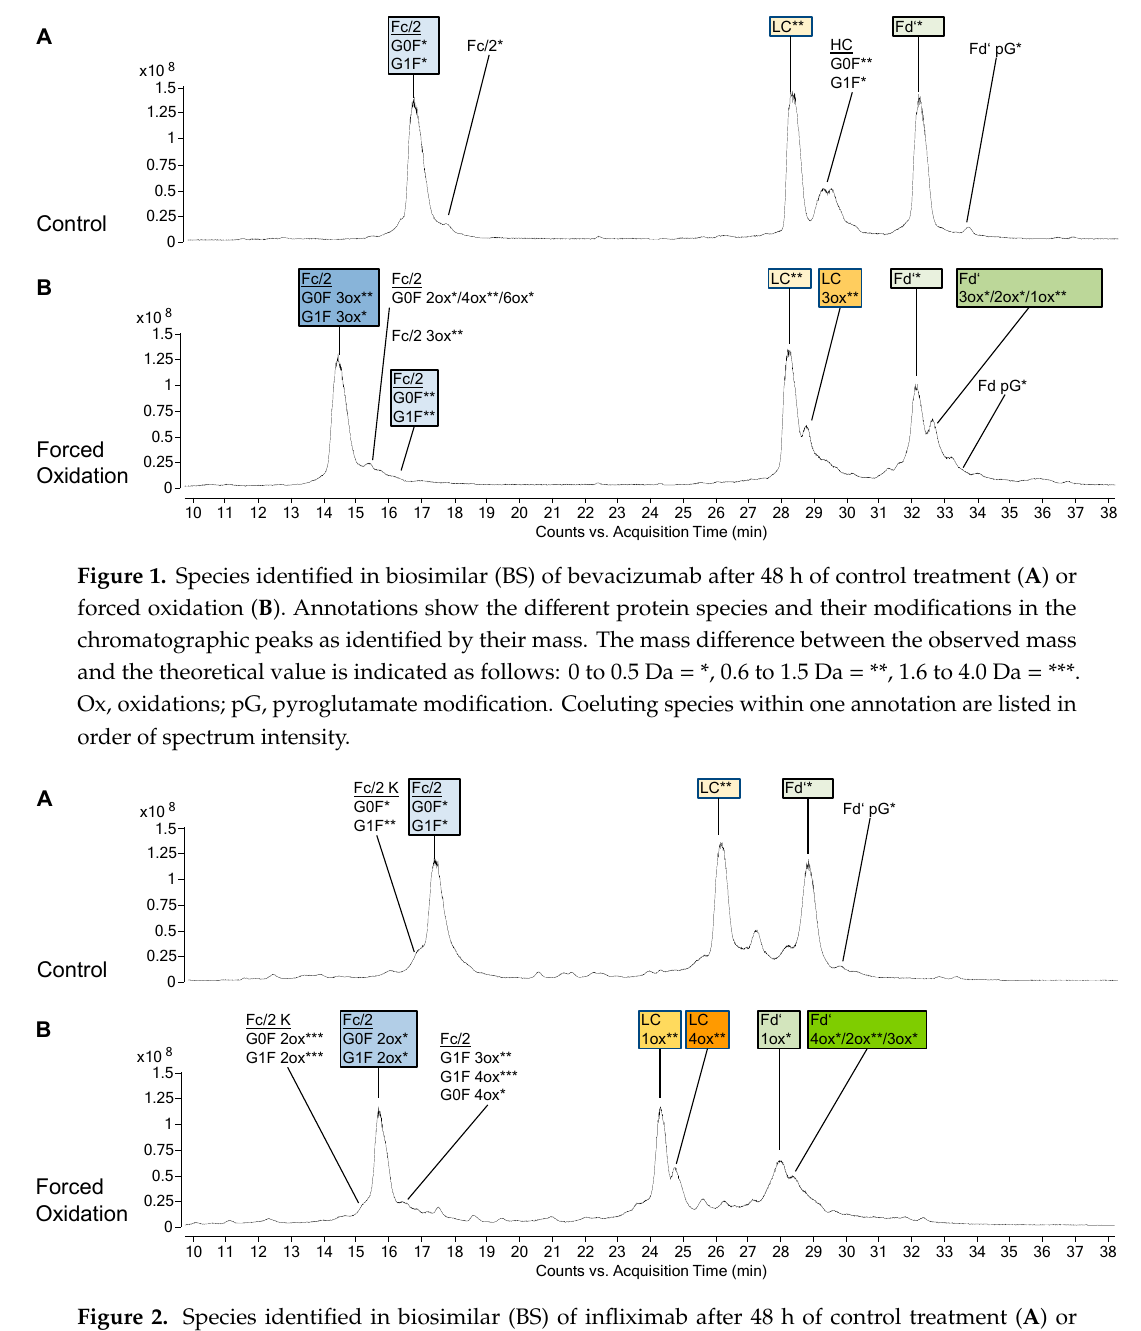
Figure 2. Species identified in biosimilar (BS) of infliximab after 48 h of control treatment ( A ) or forced oxidation ( B ). Annotations show the different protein species and their modifications in the chromatographic peaks as identified by their mass. The mass difference between the observed mass and the theoretical value is indicated as follows: 0 to 0.5 Da = *, 0.6 to 1.5 Da = **, 1.6 to 4.0 Da = ***. K, additional c-terminal lysine; Ox, oxidations; pG, pyroglutamate modification. Coeluting species within one annotation are listed in order of spectrum intensity.